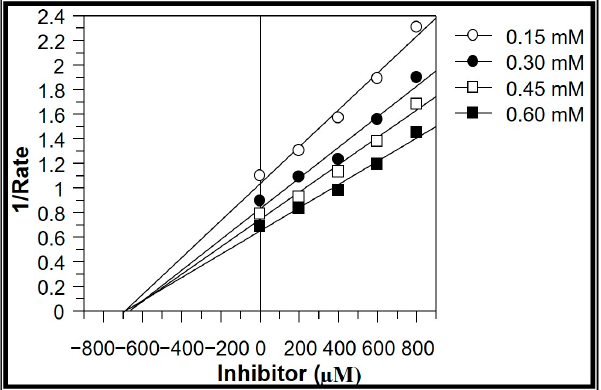
Figure 4. Dixon plot at fixed substrate concentrations.